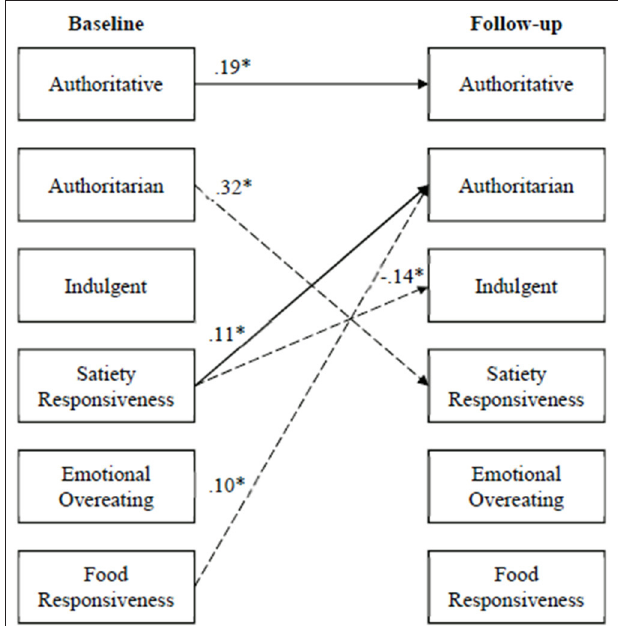
FIGURE 3 | Cross-lagged panel analysis: parental feeding styles to child appetitive traits and vice-versa (unstandardized B weights). Sold lines represent hypothesized effects; dotted lines represent effects not hypothesized. * p < 0.05.